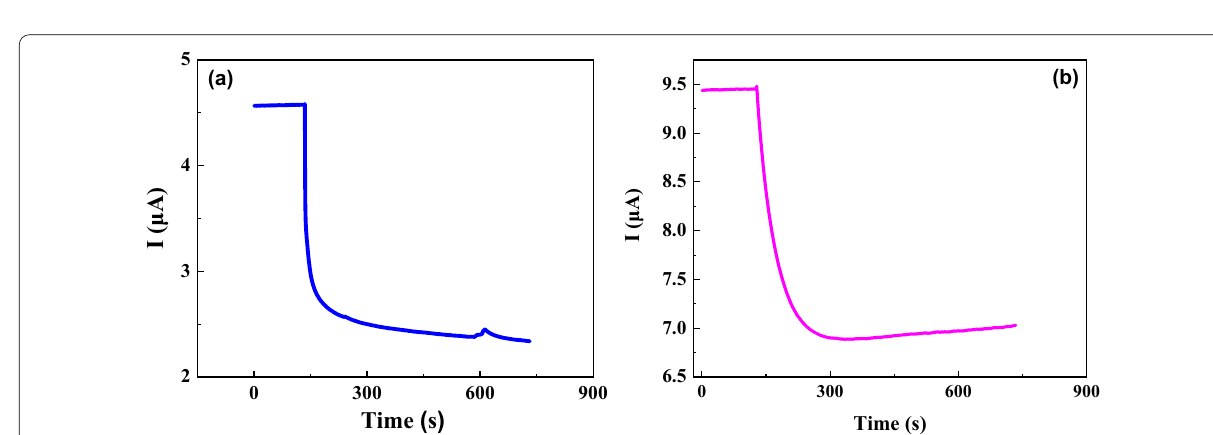
Fig. 5 Time dependence of electrical response for different cancer cells: a SUDHL8, and b OCILYS